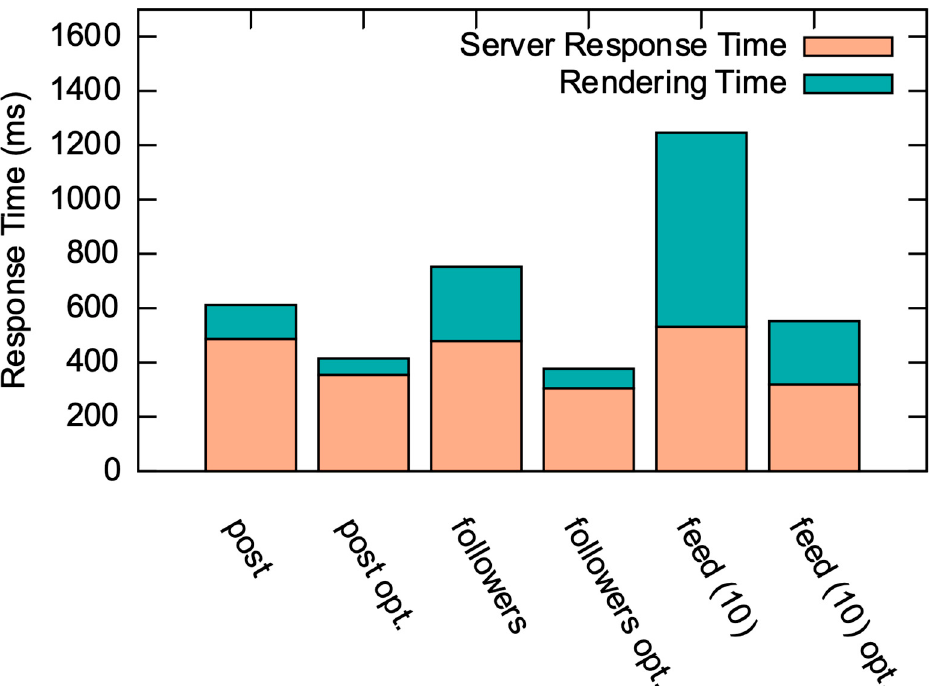
Figure 7. Time metrics of implemented endpoints between the optimized and baseline applications.